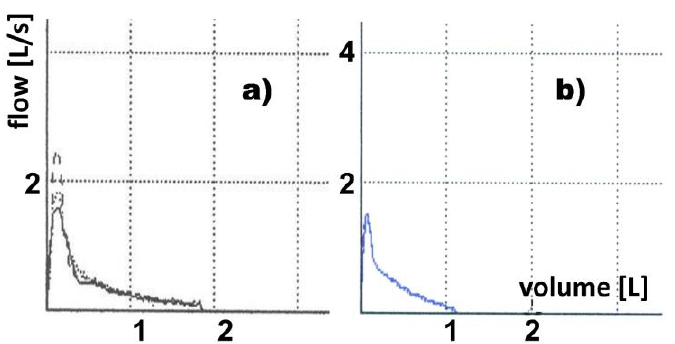
Figure A3. Examples of forced spirometry—scans of spirometer reports. The flow–volume curves registered during three spirometric measurements of real ( a ) and artificial ( b ) patients suffering from severe obstructive lung disease. Spirometry was performed three times in each of these cases. Note the high repeatability in the case of the artificial patient.